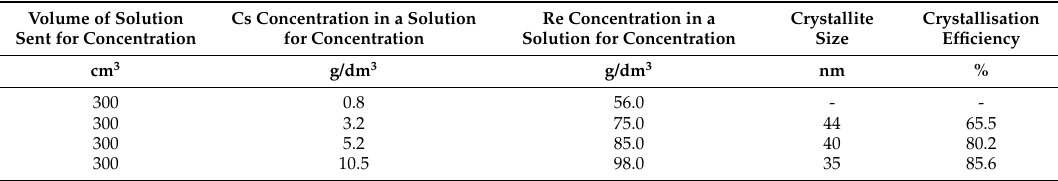
Table 10. Separation and purification of cesium perrhenate.